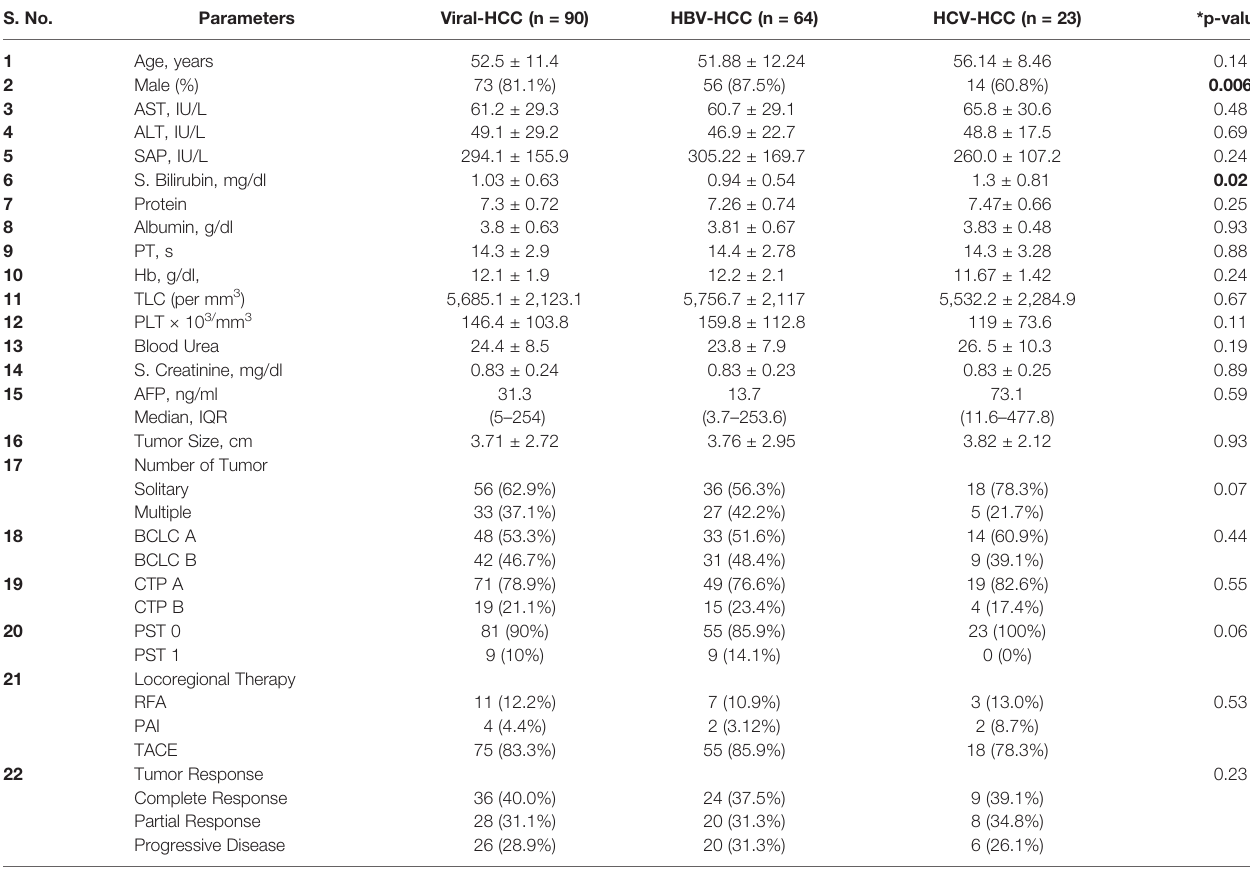
TABLE 2 | Demographic, biochemical, and clinical pro fi le of study population and comparison between HBV and HCV etiology. S.